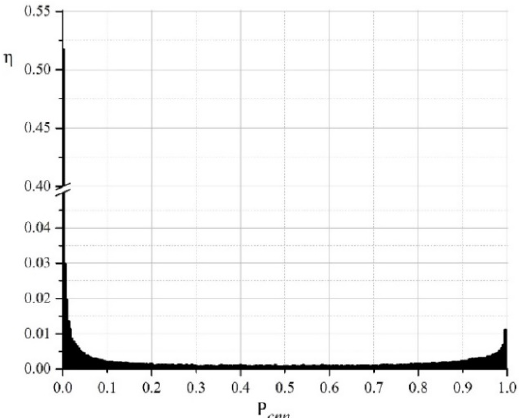
Figure 7. Normalized histogram of distribution of values P cnn ( x,y ) . η is the share of image pixels, which corresponds to the value Ρ cnn (x, y) .